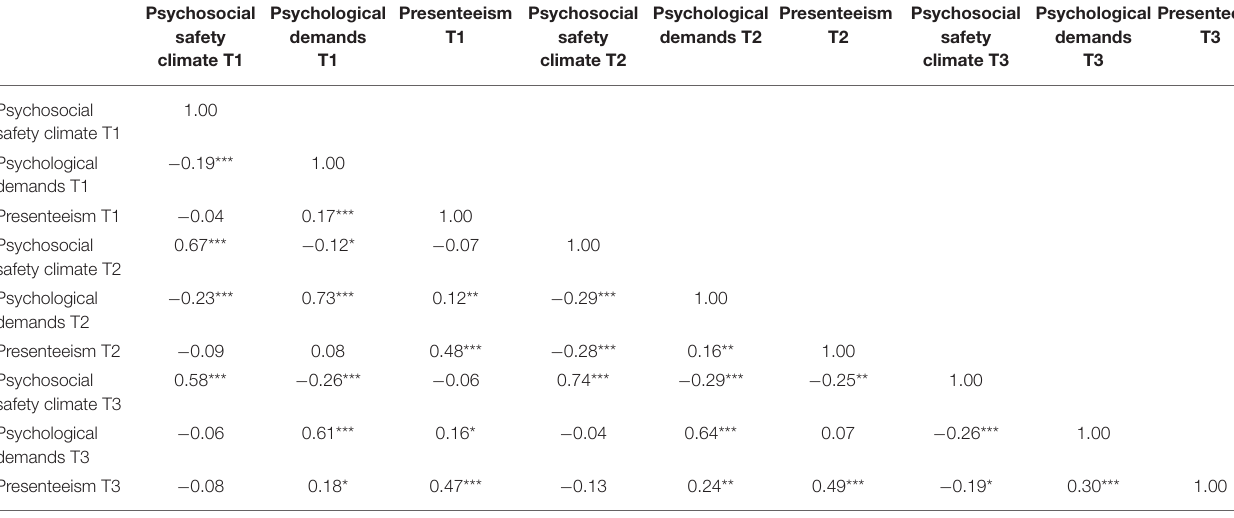
TABLE 2 | Correlations ( r ) for the study variables (T1: April 2020, T2: June 2020, and T3: December 2020) ( n = 275).